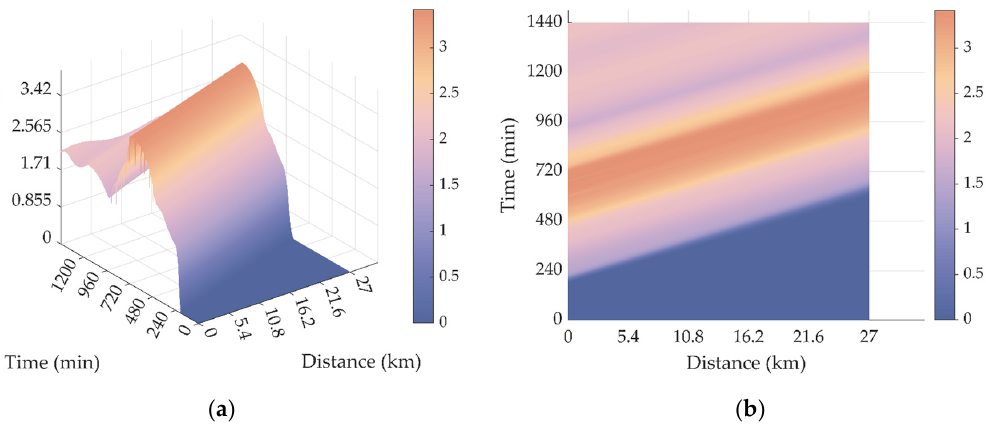
Figure 19. The distribution of hydrogen mass fraction in Pipe 6 in Scenario III: ( a ) Three-dimensional diagram; ( b ) top view.